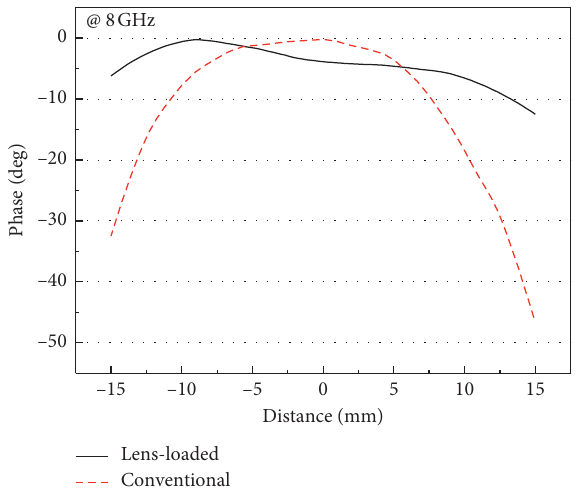
Figure 7: The simulated aperture phase error at 8GHz of the conventional and lens-loaded